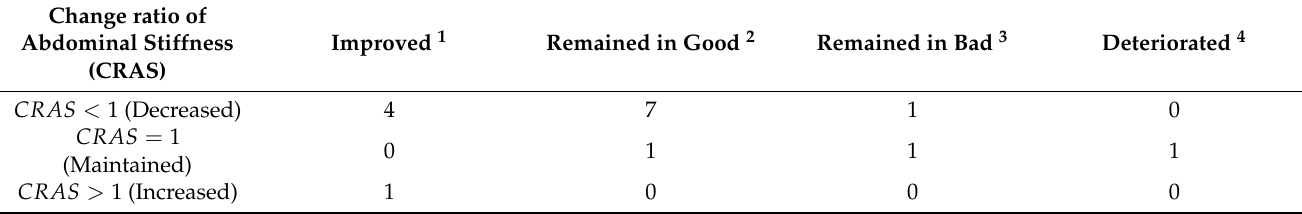
Table 2. Relationship between change in abdominal stiffness (CRAS: change ratio of abdominal stiffness) and change in BSS. Change ratio of Abdominal